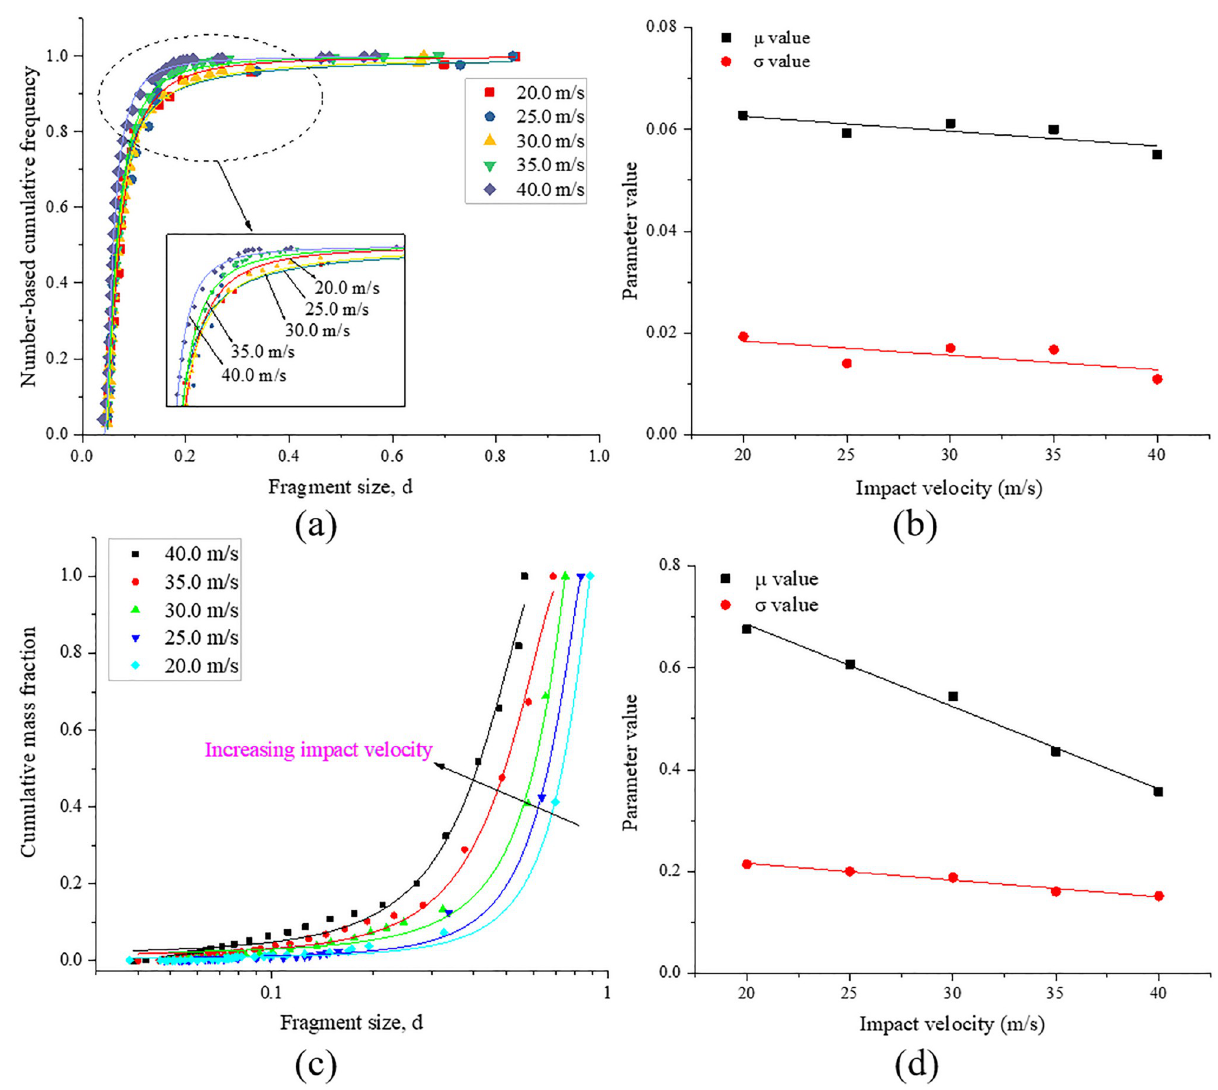
Fig 18. Cumulative size distribution of fragments based on (a) mass and (c) number (the solid lines are fitted curves using the generalized extreme value distribution); (b) and (d) show the corresponding fitting parameters μ and σ .